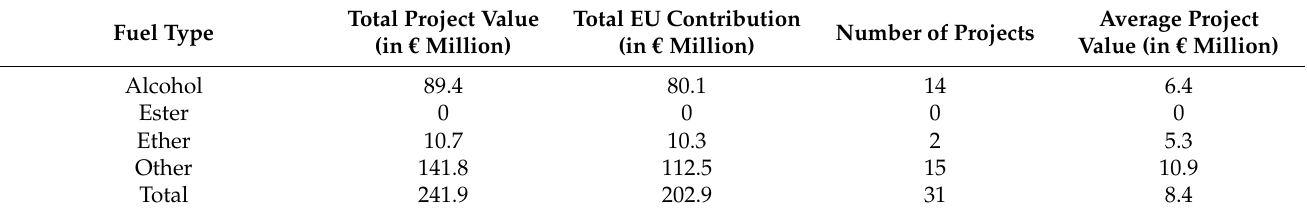
Table 4. Projects and levels of funding identified for alcohols, ethers and esters